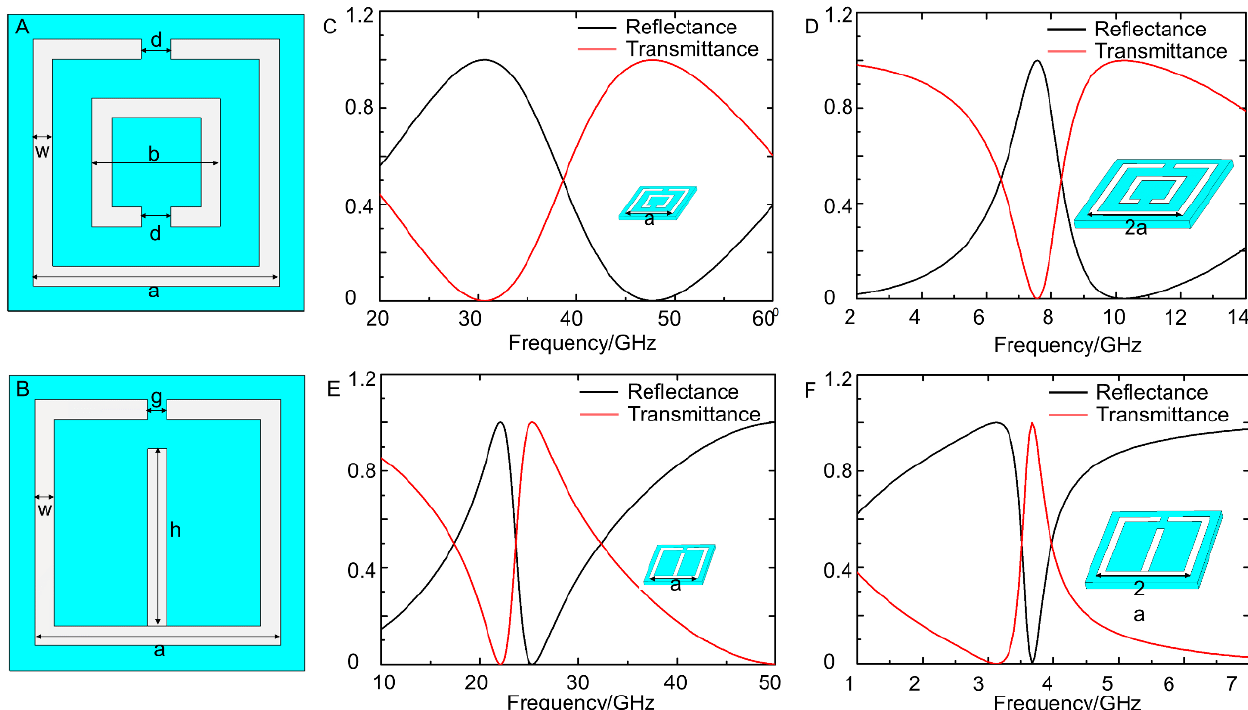
Figure 2. ( A ) The design of a DSRR unit; ( B ) the design of an ESRR unit; ( C , D ) the simulated reflectance–transmittance curves of DSRR units when the outer side length was 2.5 mm and 5 mm, respectively; ( E , F ) the simulated reflectance–transmittance curves of ESRR units at 2.5 mm and 5 mm, respectively.